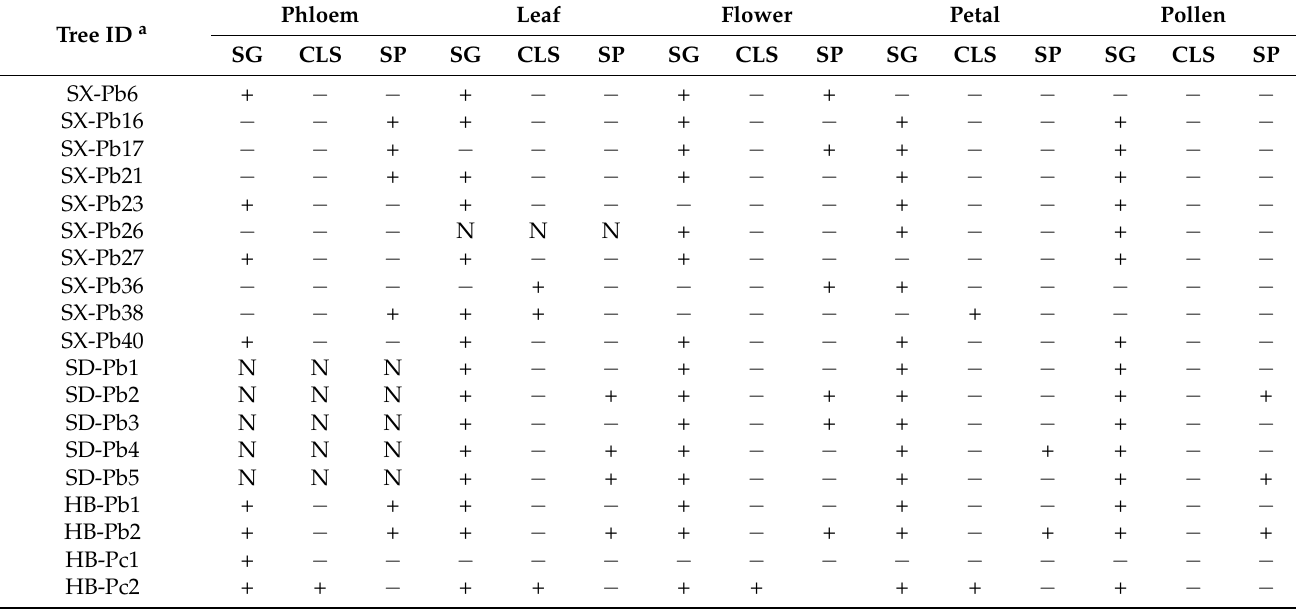
Table 2. The detection of three viruses in the different tissues of P. betulaefolia and P. calleryana . Tree ID